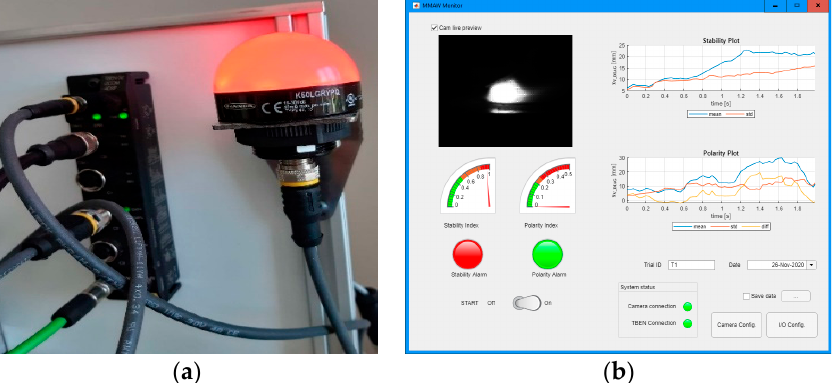
Figure 22. ( a ) View of I/O module—Turck TBEN TBEN-S2-2COM-4DXP, Turck GmbH & Co. KG, Mulheim, Germany, and indicating light Banner K50LGRYPQ; ( b ) screenshot of System A GUI, made in Matlab App Designer.